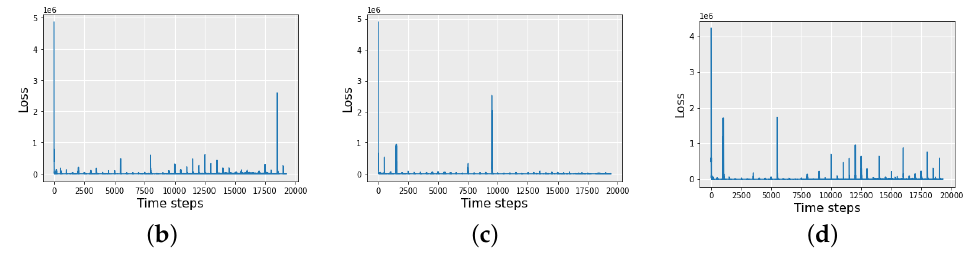
Figure 8. Loss convergence of the DQN algorithm in a heterogeneous MAS, including N = 5 agents in P = 3 different clusters, during 20,000 time steps by considering the novel distance-based reward. ( a ) DQN average loss in a leaderless MAS. ( b ) DQN average loss in a leaderless MAS by considering time-delay. ( c ) DQN average loss in a leader-follower MAS. ( d ) DQN average loss in a leader-follower MAS by considering